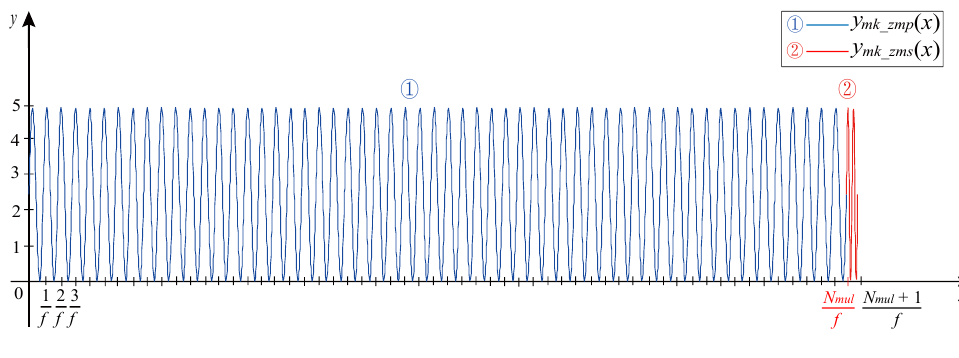
Figure 8. No missing teeth magnetoelectric CKP